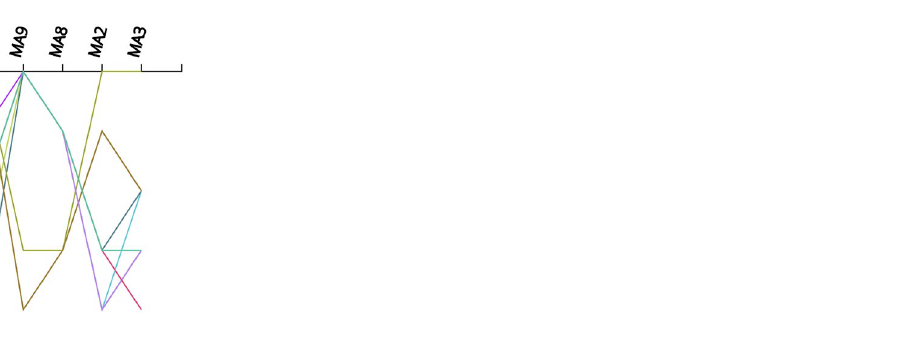
Figure 4. Comparisons of rankings over all normalization/aggregation combinations (5 alternatives).